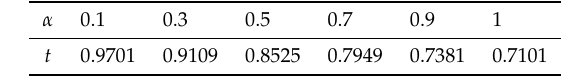
Table 5. Switching points for different values of α